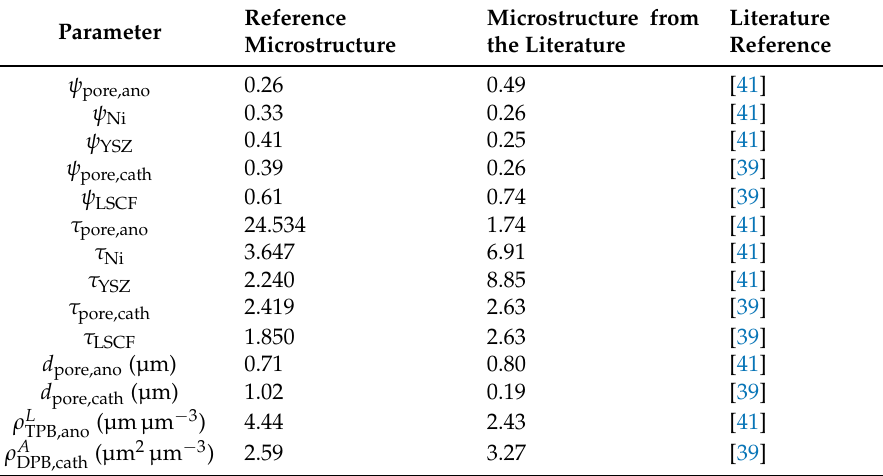
Table 13. Reference microstructure for the numerical